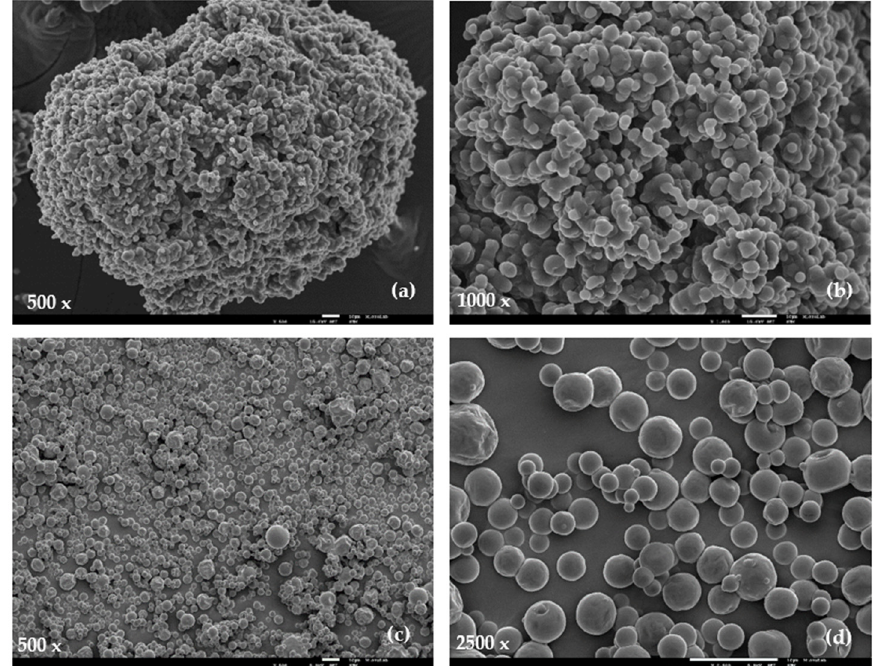
Figure 3. SEM images of particles with encapsulated extracts. Spray dried water extract after being freeze dried (SD-W/FD) ( a , b ); spray dried ethanol-water (80:20) extract (SD-E:W 80:20) ( c , d ).